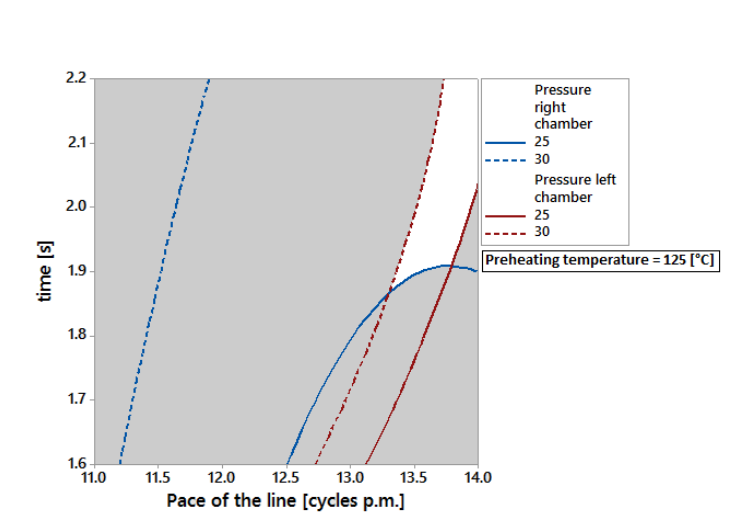
Figure 14 – Overlaid contour plot of Pressure of right chamber and left chamber vs. Time and Pace of the line. Interval of response from 25% to 30%.